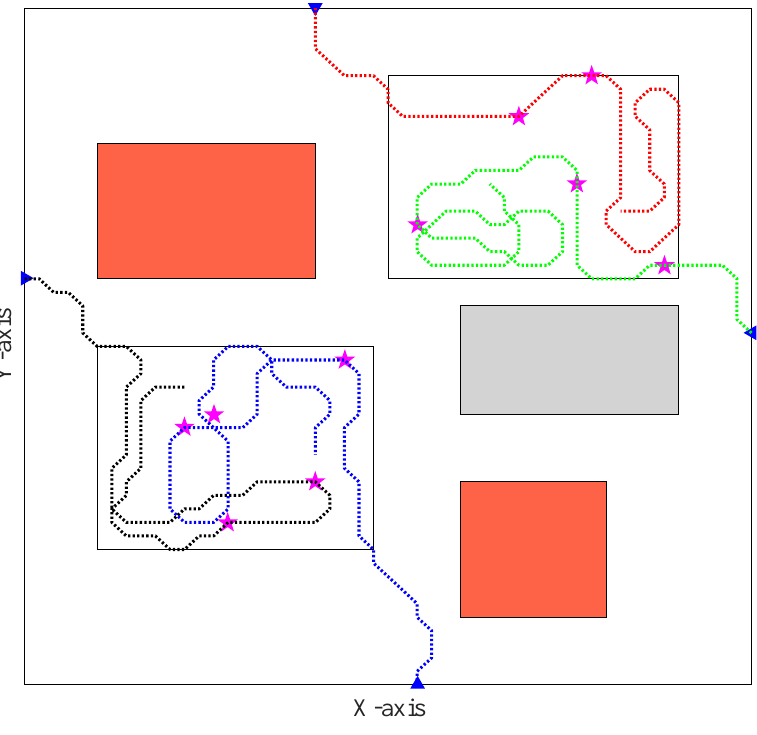
Figure 7. Search trajectory with N p = 5.